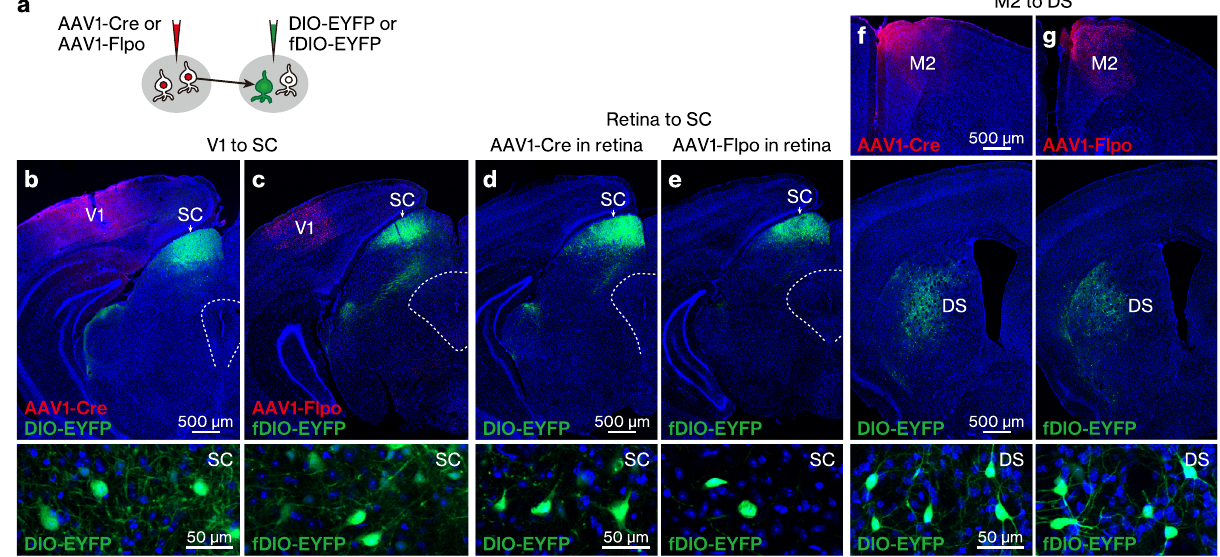
Fig. 2 Anterograde transneuronal spread of AAV1-Cre and AAV1-Flpo. a Schematic of the anterograde transneuronal labelling. b – g Anterograde transneuronal spread of AAV1-Cre ( b , d , f ) and AAV1-Flpo ( c , e , g ) from the V1 to ipsilateral SC ( b , c ), retina to contralateral SC ( d , e ), and M2 to contralateral DS ( f , g ) pathways. The Cre (red) and 3×FLAG-tagged Flpo (red) were detected with anti-Cre and anti-FLAG antibodies, respectively. All images represent coronal sections, and the bottom images show the labelled EYFP (green)-positive somata in the SC ( b – e ) and DS ( f , g ). Blue, DAPI. N = 2 ( b – e , g ) and 3 ( f ) mice under each experimental condition. The numbers of EYFP-positive cells per section in either the SC ( b – e ) or DS ( f , g ) were as follows: 32.2 ± 41.8 ( b ), 43.5 ± 0.7 ( c ), 35.6 ± 7.0 ( d ), 27.3 ± 38.5 ( e ), 87.4 ± 10.0 ( f ), and 71.3 ± 10.0 ( g ). AAV1 adeno-associated virus serotype 1,